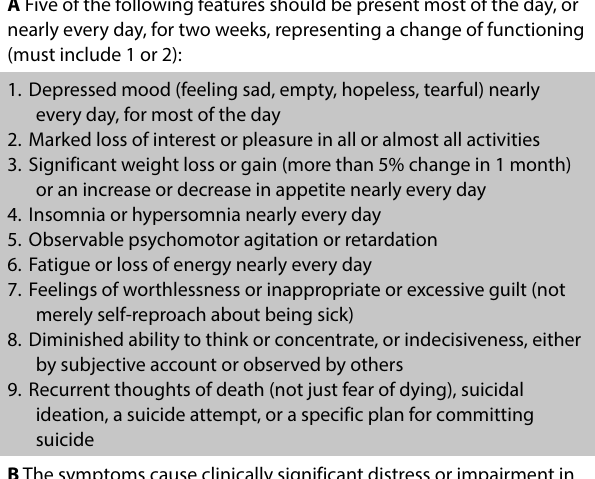
Table II: Major Depressive Episode - Abridged DSM-V criteria 19 A Five of the following features should be present most of the day, or nearly every day, for two weeks, representing a change of functioning (must include 1 or